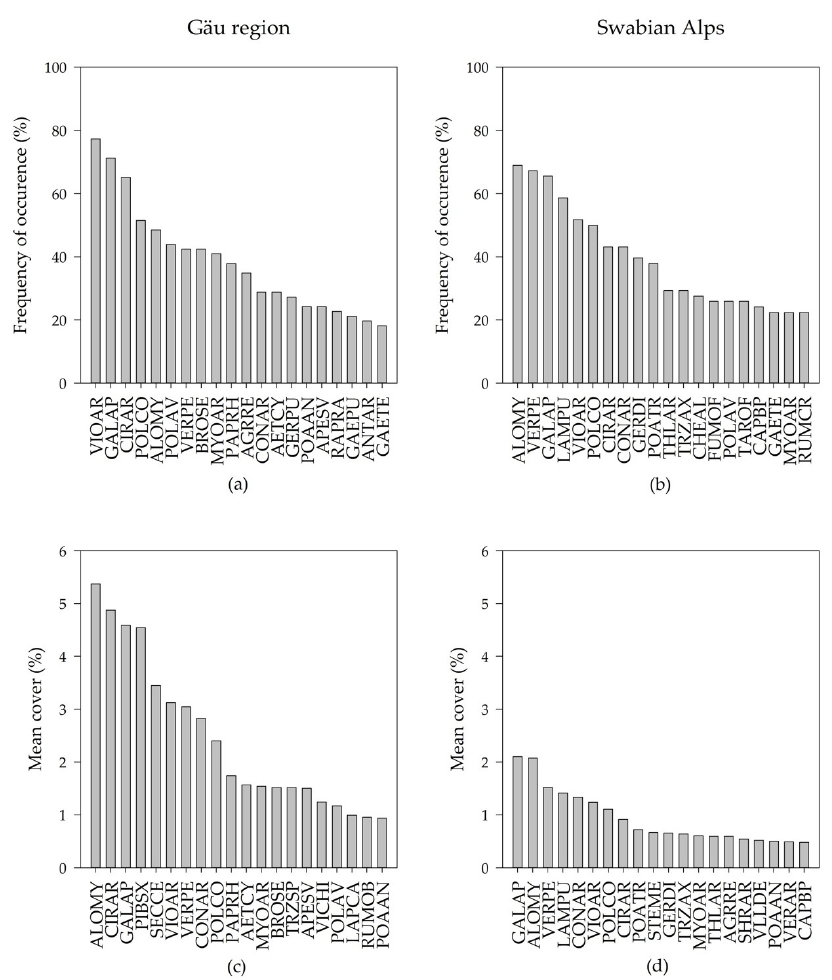
Figure 3. Values of ( a , b ) frequency of occurrence (%) and ( c , d ) mean cover (%) for those 20 weed species with the highest occurrence or soil cover in the ( a , c ) Gäu region or the ( b , d ) Swabian Alps. Abbreviation of weed species according to the EPPO (European and Mediterranean Plant Protection Organization)